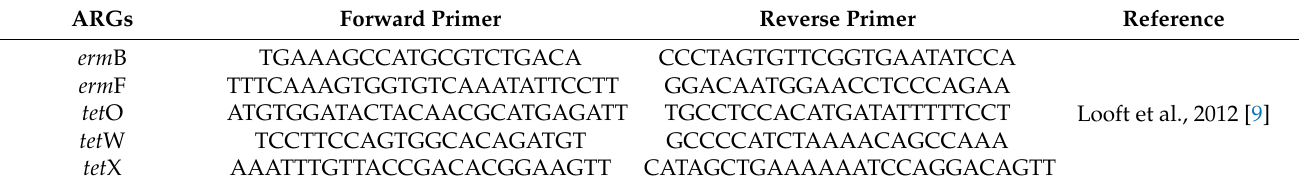
Table 2. Primers used to quantify selected resistance genes in calf pooled fecal samples using qPCR.